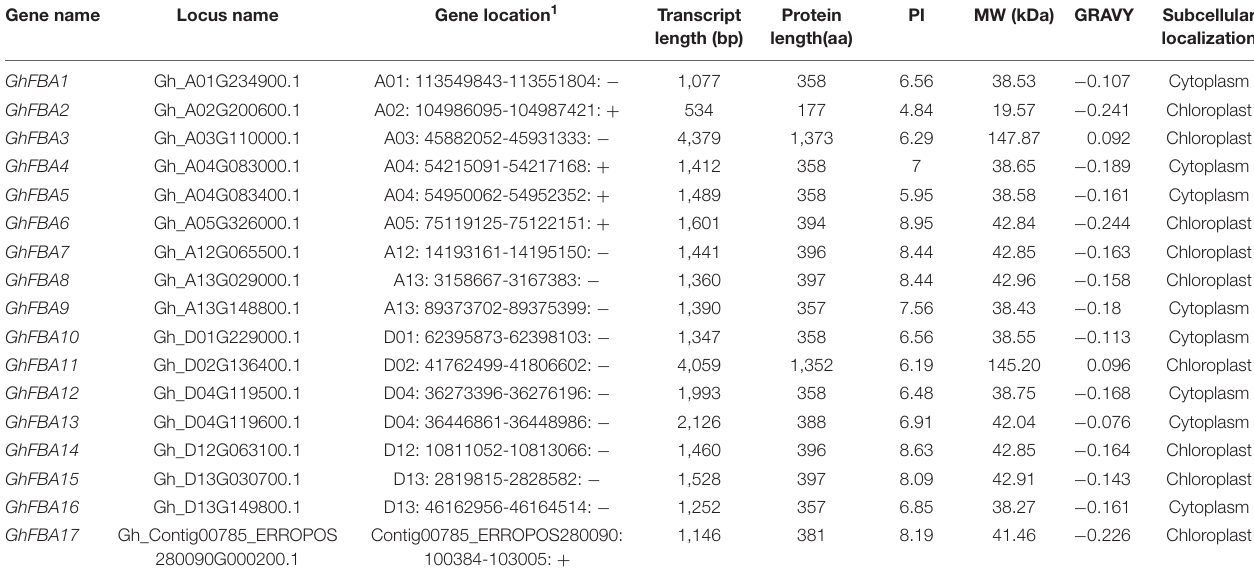
TABLE 1 | Characteristics information of FBA family genes in G.hirsutum .